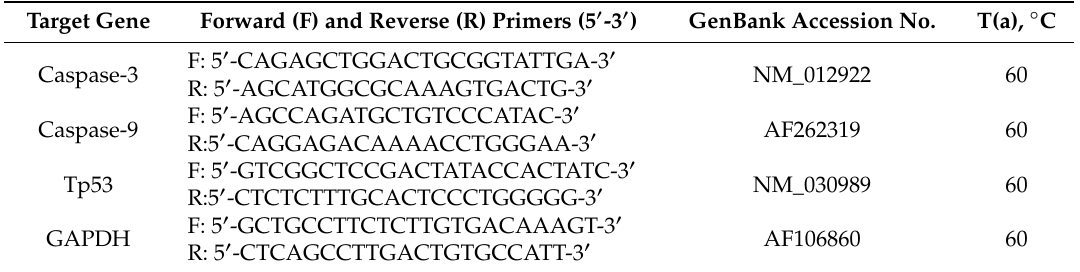
Table 4. Test of primers used for qRT-PCR expression analysis of apoptosis-related genes of rats. Target